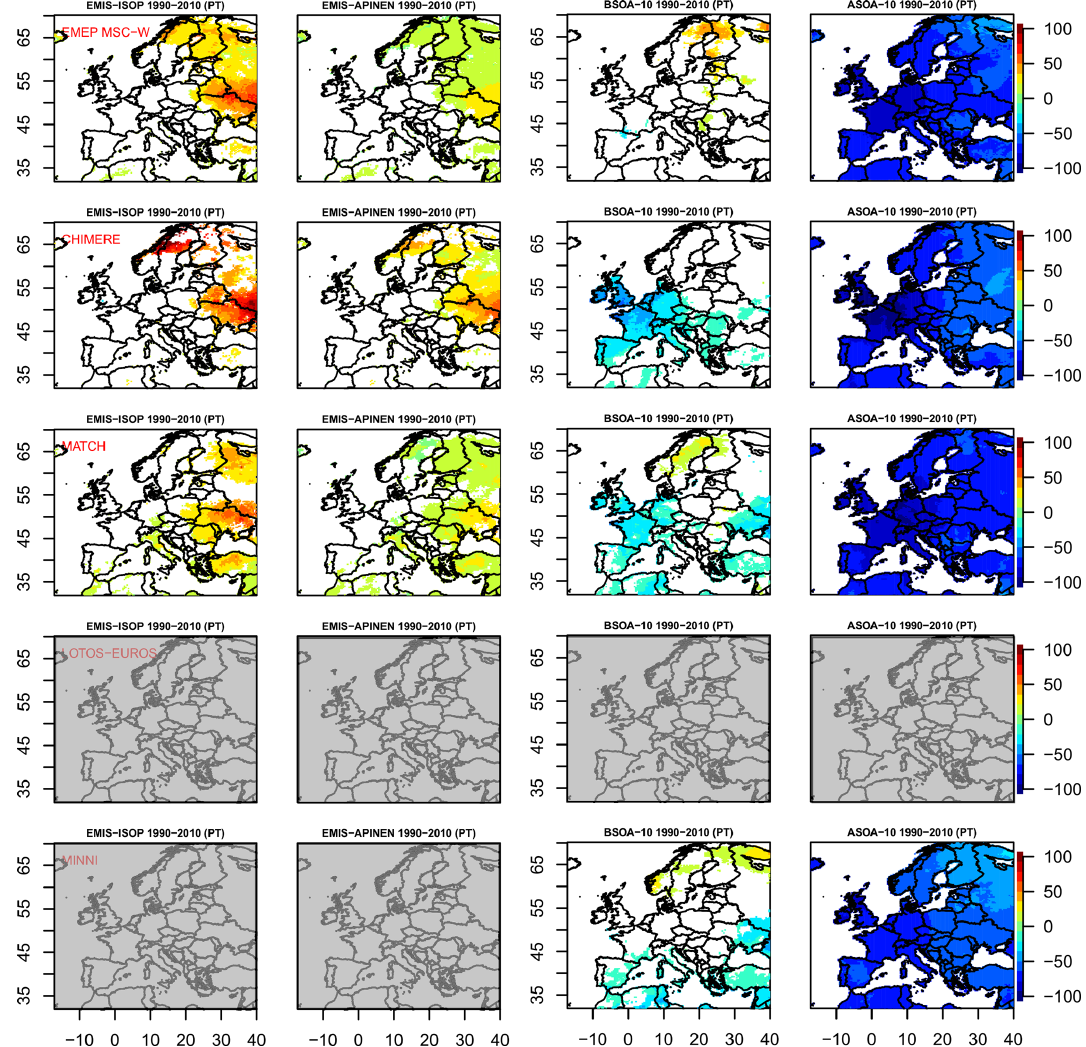
Figure 16. Modeled relative trends in isoprene and monoterpene emissions for the PT period (1990–2010, first and second columns) and biogenic and anthropogenic SOA relative trends for the PT period (1990–2010, third and fourth columns) as predicted by all the models (rows; from top to bottom: EMEP MSC-W, CHIMERE, MATCH, LOTOS-EUROS, MINNI). White areas indicate non-significant trends. Scale was saturated at 100% to facilitate the comprehension of the panel. Grey panels indicate missing data.